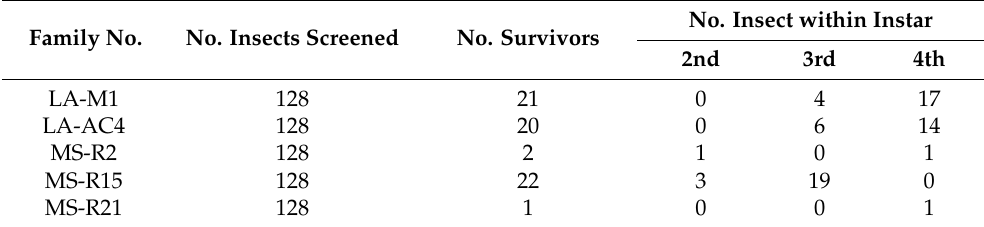
Table 3. Potential resistant families containing survivors of Helicoverpa zea in the F 2 screen on 3.0 µ g/cm 2 of Vip3Aa39